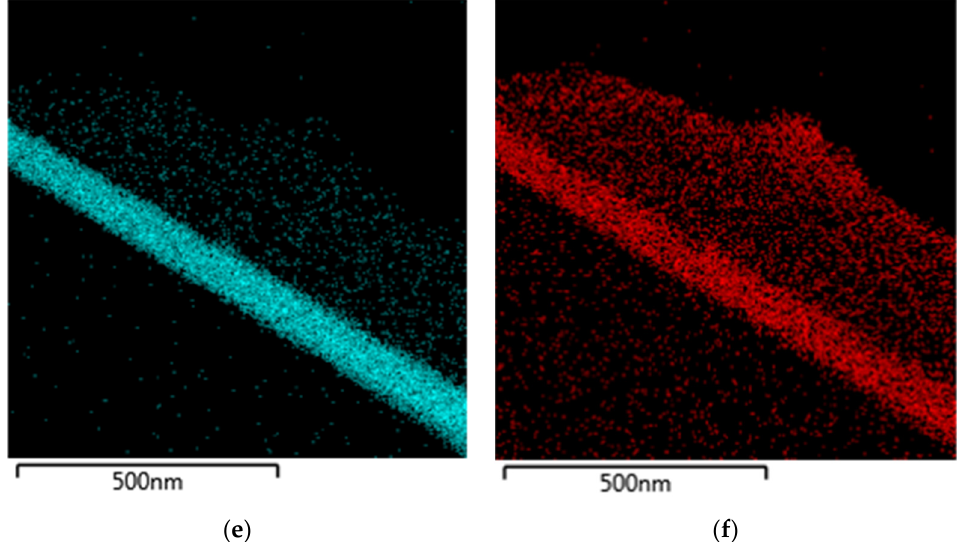
Figure 3. ( a ) Low and ( b ) high magnification TEM micrographs of Cu/AZO/Si sample annealed at 300 °C, respectively. EDS map of ( c ) Si, ( d ) Cu, ( e ) Zn, and ( f ) O elements.